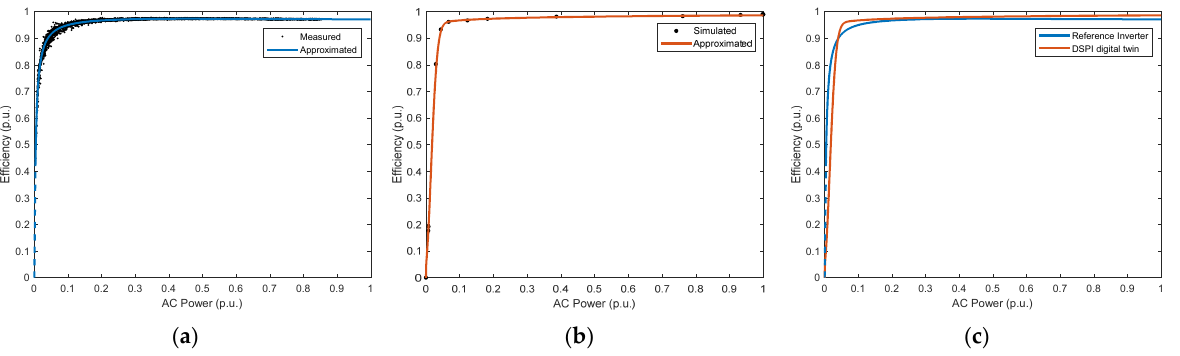
Figure 8. Efficiency characteristics of the reference inverter ( a ), the DSPI digital twin model ( b ), and comparison of them ( c ).